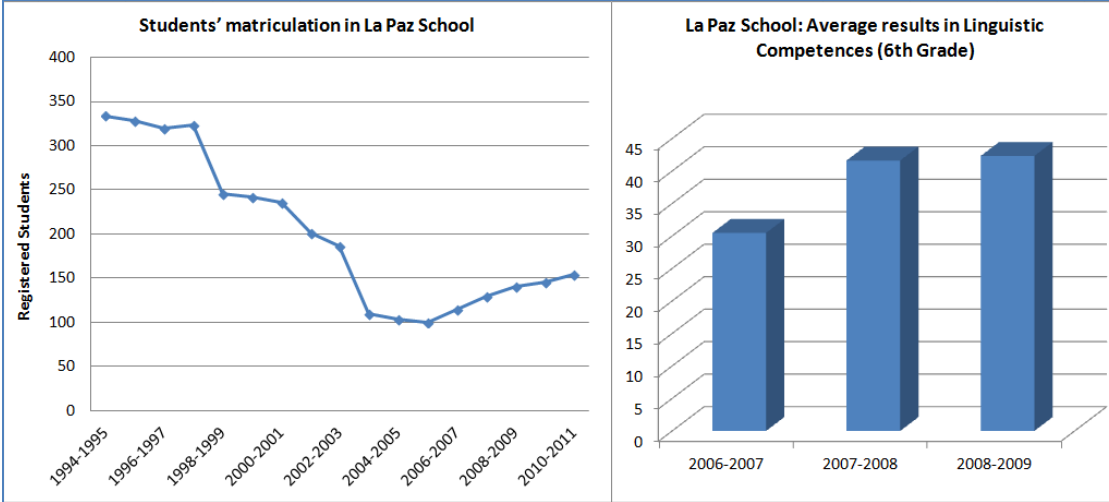
Figure 1 . Pupils’ matriculation and results in linguistic competences in La Paz